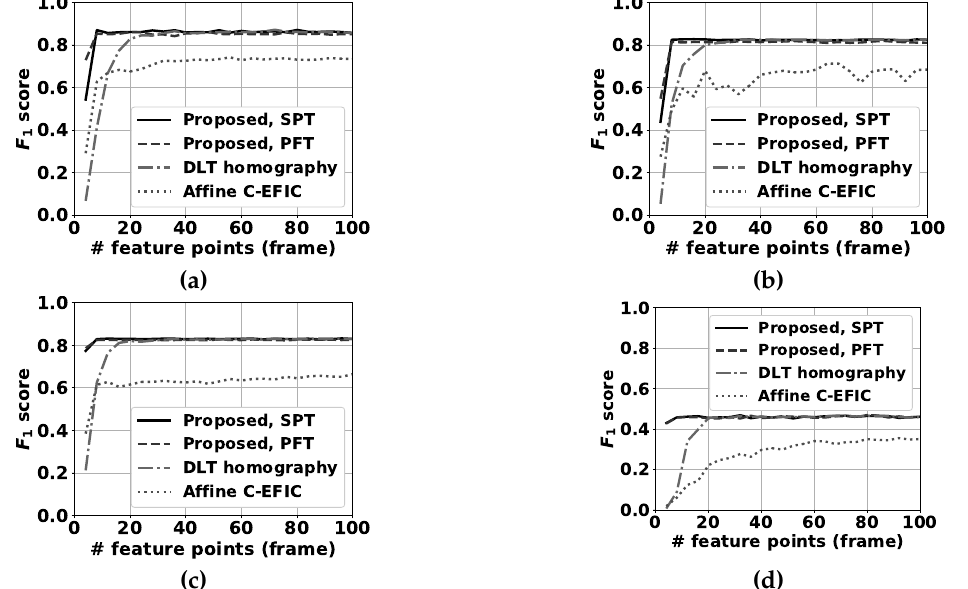
Figure 10. F 1 scores for the full FGBG segmentation method in the fixed tilt sequences. The proposed methods for panning with fixed tilt (PFT) method and the simultaneous pan and tilt (SPT) method are compared to the DLT homography method [24] and the affine compensation mechanism used before in C-EFIC [3] for 4 sequences; ( a ) classroom 5 ◦ tilt, ( b ) classroom 15 ◦ tilt, ( c ) classroom 25 ◦ tilt, ( d ) parking outdoor